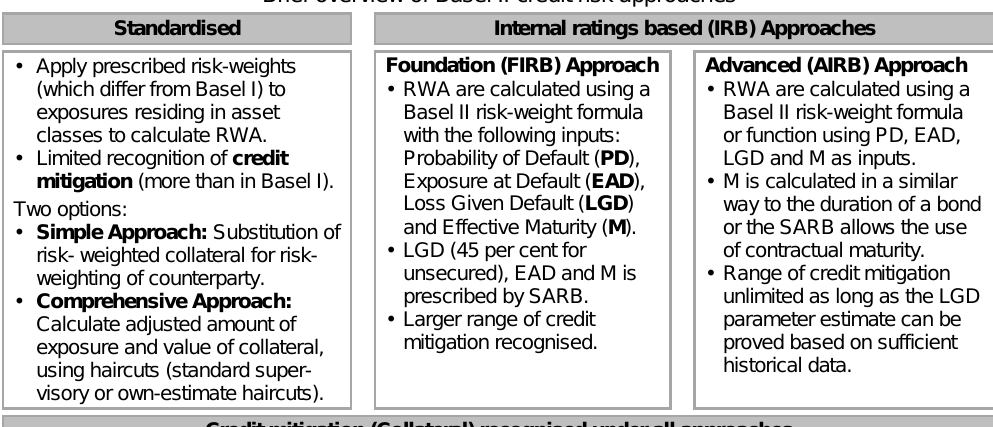
Brief overview of Basel II credit risk approaches Standardised Internal ratings based (IRB)